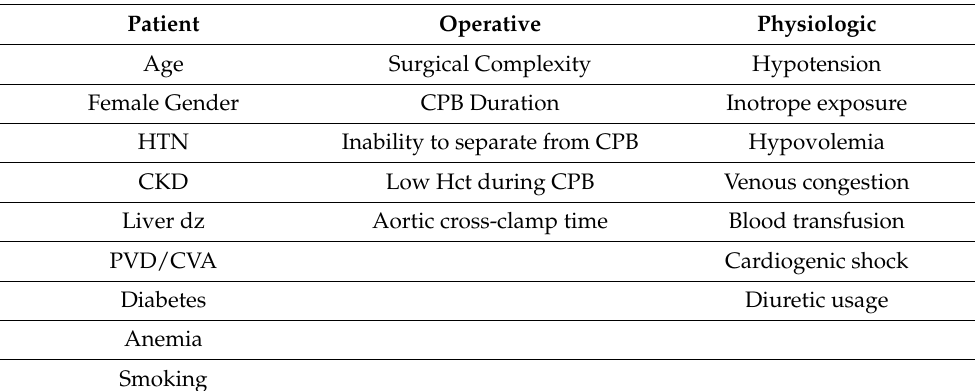
Table 2. Risk factors for CSA-AKI